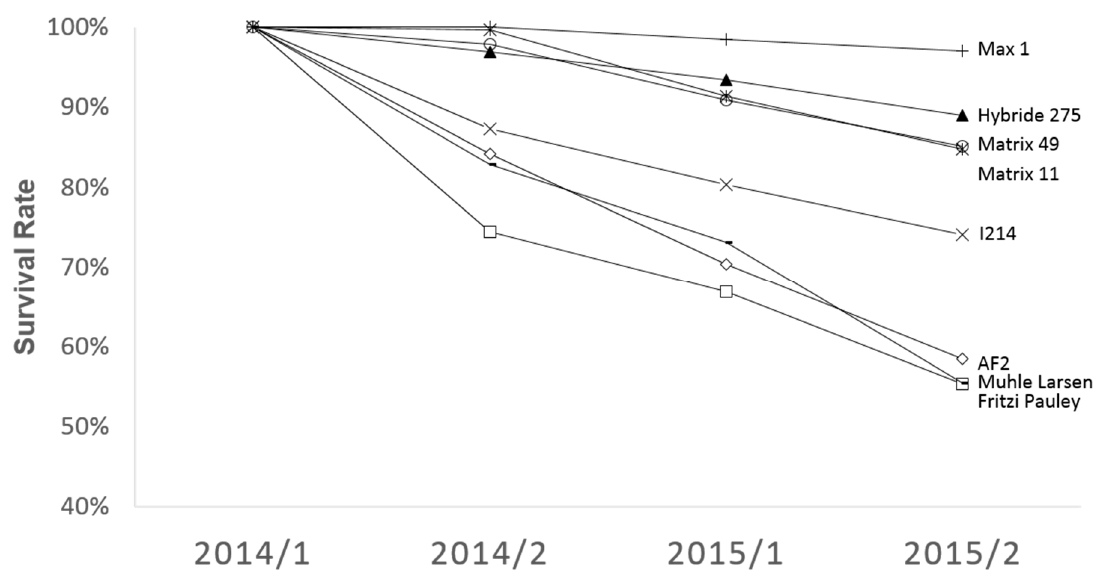
Figure 4. Survival rates of eight genotypes across sites and stand types on the single tree level in the first two years after planting. The survival rate was calculated as the ratio of living poplar plants of the respective genotype at a given time to the total number of planted trees of that genotype. The survey was done before (/1) and after (/2) the vegetation period in 2014 and 2015.